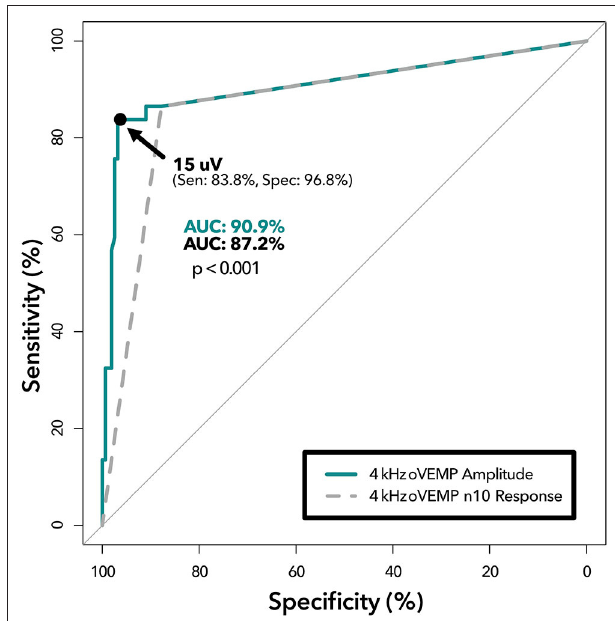
FIGURE 2 | ROC analysis of 4kHz oVEMP n10 response vs. amplitude. Receiver operating characteristic curves demonstrating diagnostic ability of 4kHz oVEMP amplitude at various cut-offs (solid line) and 4kHz oVEMP n10 response (i.e., single amplitude cut-off at > 0 uV) (dashed line). The area under the curve (AUC) quantifies the accuracy of detecting SCD for amplitude (top) and n10 response (bottom) with a p < 0.001 suggesting significant difference. The data point on the solid line represents the optimal threshold (15 uV) with (sensitivity, specificity)